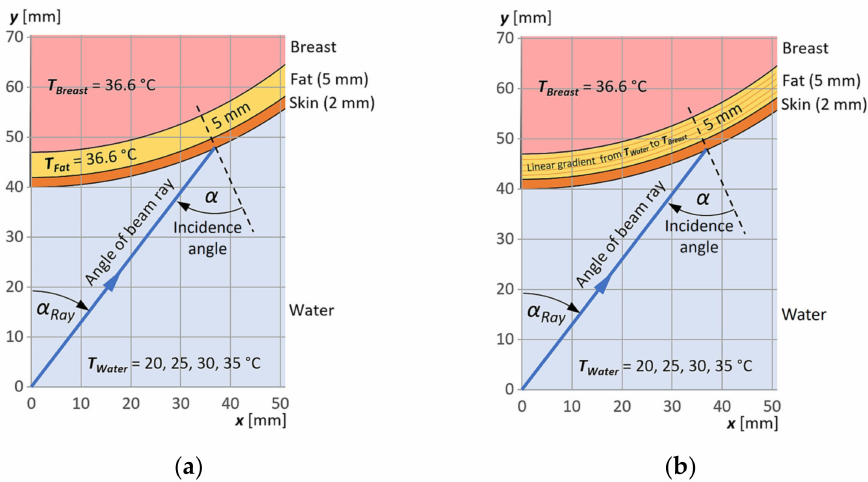
Figure 8. Layered computational models of the water/skin/breast fat/breast glandular tissue media: ( a ) assuming body temperature in the breast fat layer; ( b ) assuming a linear temperature gradient changing from water temperature to body temperature in the breast fat